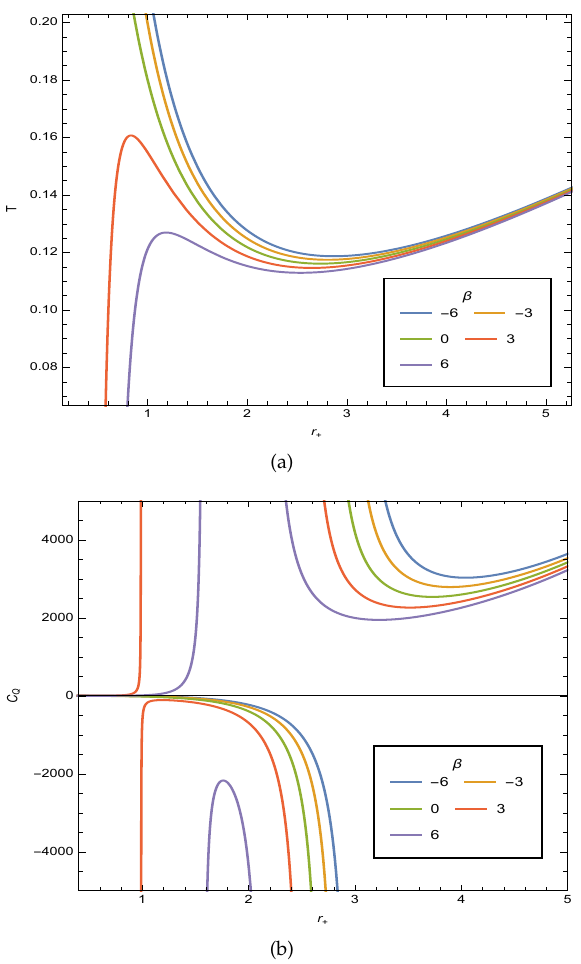
Figure 1. ( a ) The black hole temperature with respect to event horizon r + . ( b ) The black hole heat capacity with respect to the event horizon r + . The parameters are n = 5, α = 2, a = 0.2, λ = − 0.2.